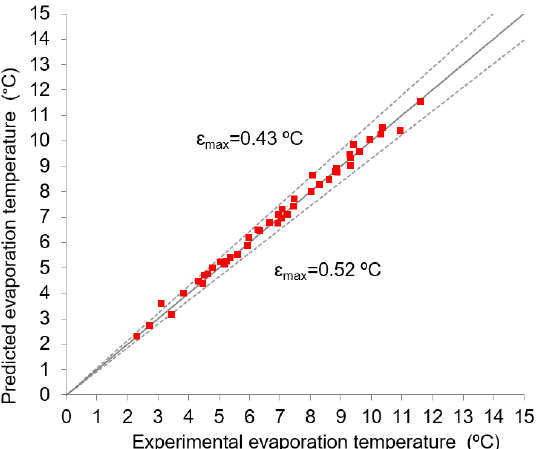
Figure 11. The deviation between calculated and experimental values of the refrigerant temperatures.